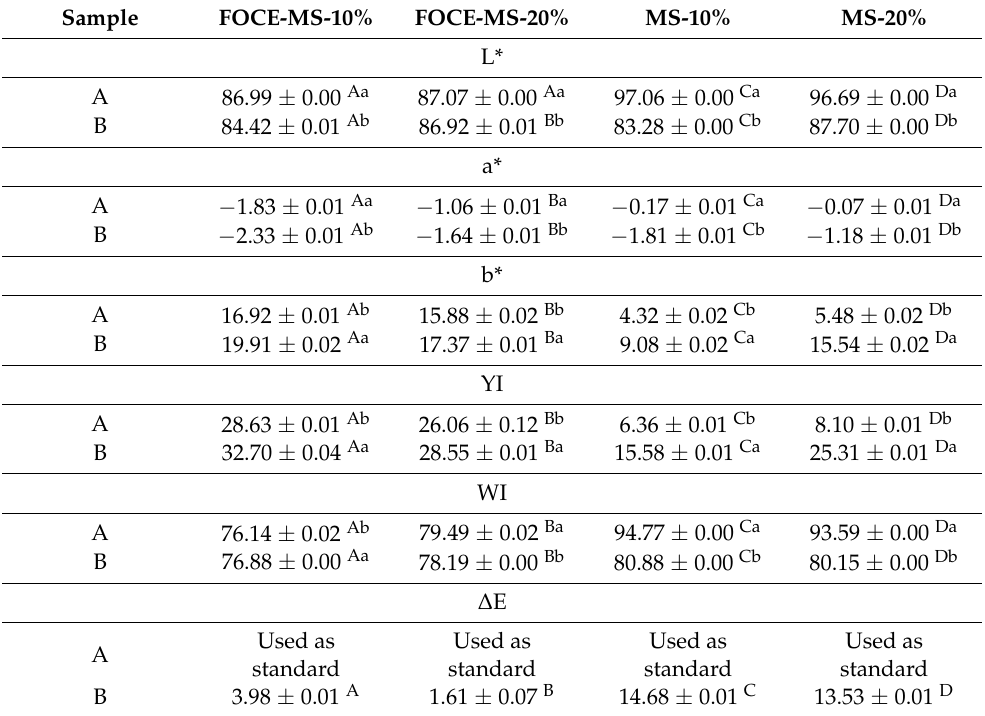
Table 6. Color of emulsions before spray drying (A) and after reconstitution